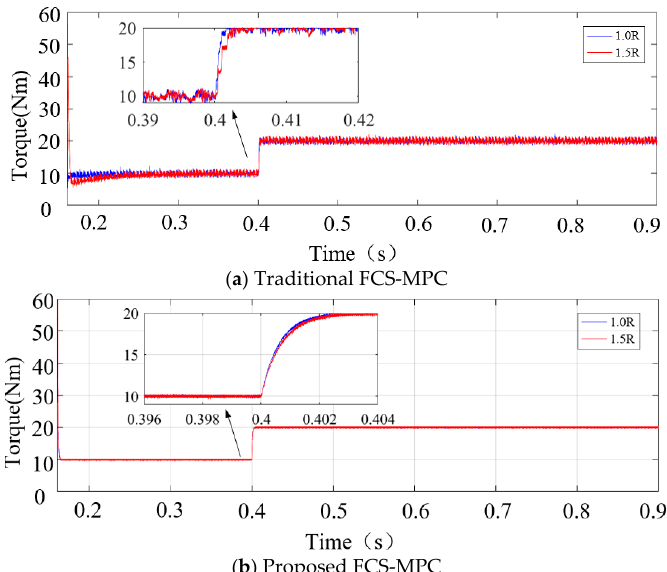
Figure 8. Torque ripple simulation when the resistance is changed.